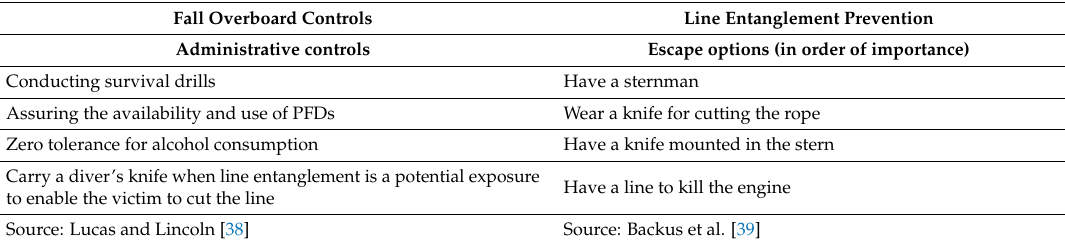
Figure 4. A vessel with paravane stabilizer deployed. Courtesy Alaska Fisheries Development Foundation